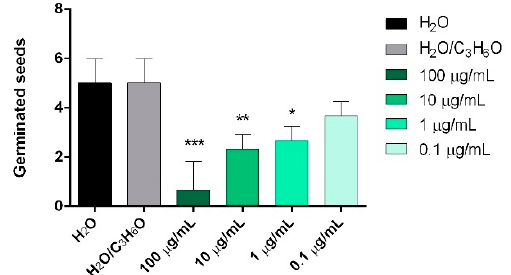
Figure 2. Phytotoxic activity of P. vera EO against germination of Portulaca oleracea L., 120 h after sowing. Results are the mean ± standard deviation ( n = 3) of three independent experiments. * p < 0.05, ** p < 0.01, *** p < 0.001 compared to control (ANOVA followed by Dunnett’s multiple comparison test).